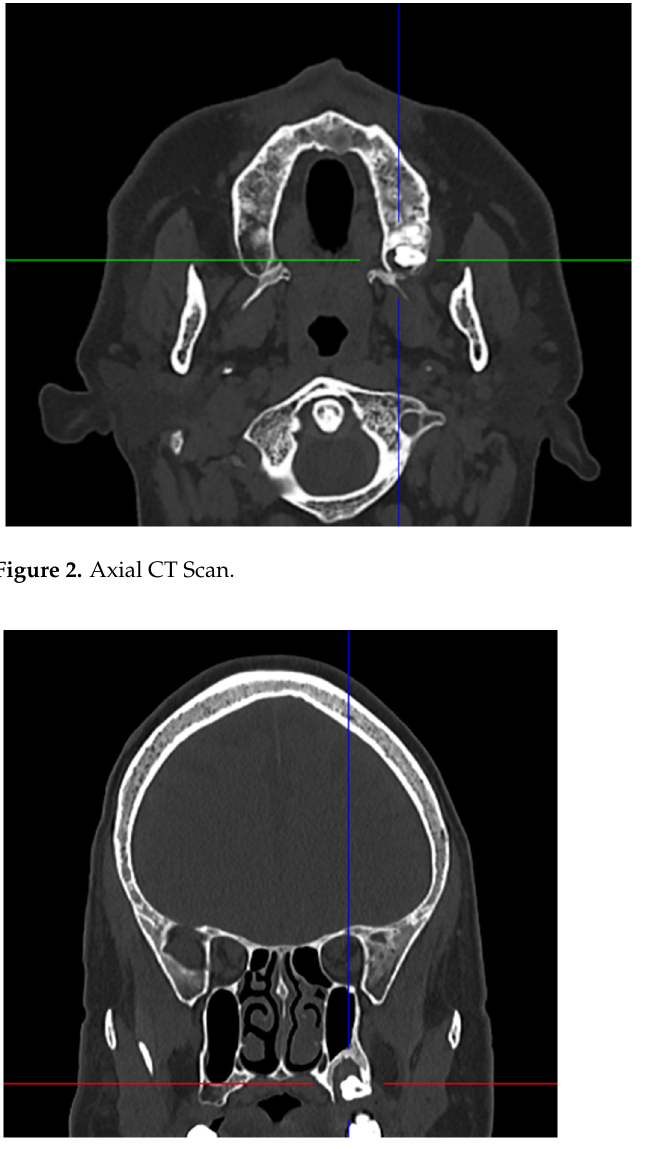
Figure 3. Coronal CT Scan.